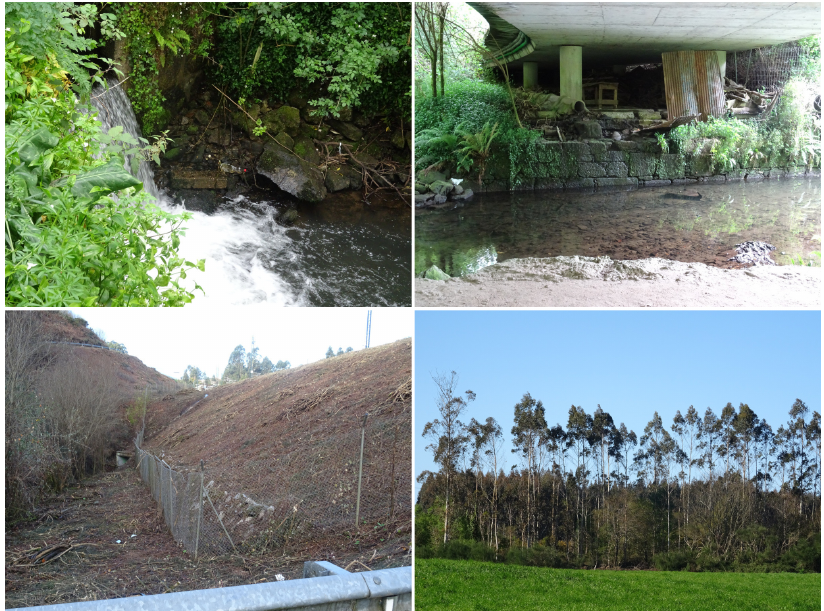
Figure 3. Threats to riparian zones include obstacles in the course of the river, pollution, deforestation, and eucalyptus plantations (Santiago de Compostela,